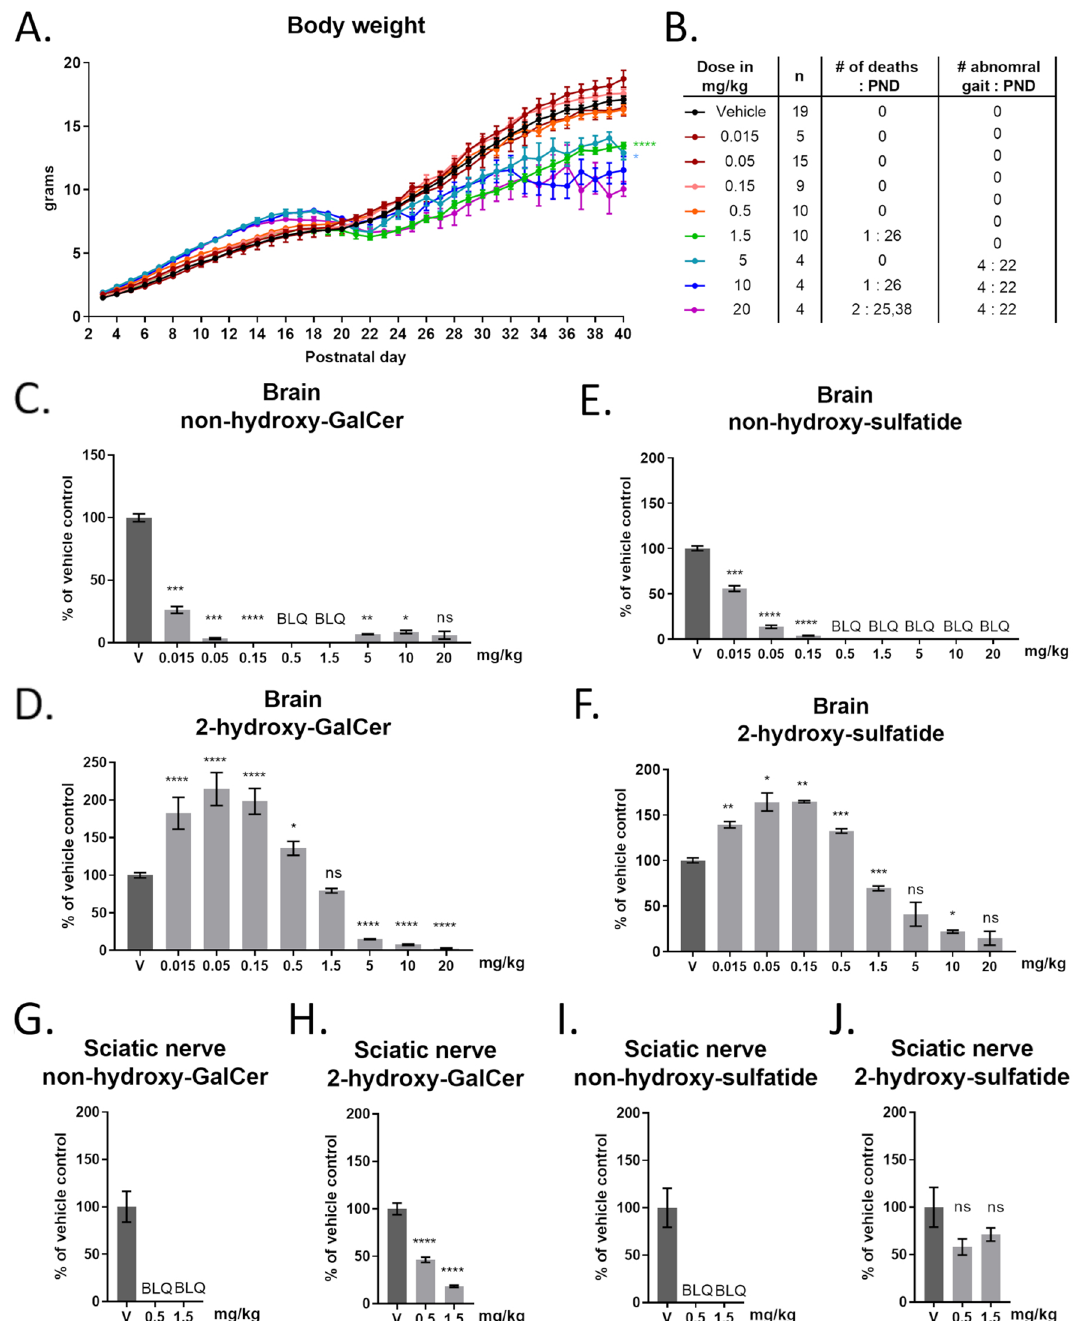
Figure 3. Tolerability and biochemical changes in young mice treated with S202. Weight profiles of neonatal mice (n = 4–19) treated with daily IP S202 (mg/kg/day) from PND3 to PND40 ( A ) and occurrence of animal deaths and development of abnormal gait ( B ). LC–MS quantification of brain non-hydroxy-GalCer ( C ), 2-hydroxy-GalCer ( D ), non-hydroxy-sulfatide ( E ), and 2-hydroxy-sulfatide ( F ) from mice treated with S202. Sciatic nerve non-hydroxy-GalCer ( G ), 2-hydroxy-GalCer ( H ), non-hydroxy-sulfatide ( I ), and 2-hydroxy- sulfatide ( J ) from mice treated with S202. Refer to the Materials and Methods section for significance